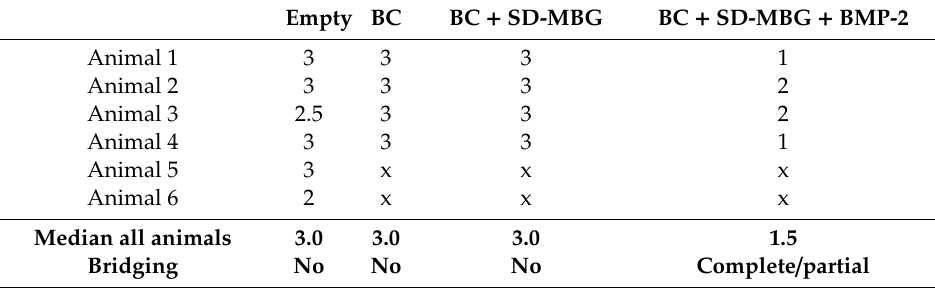
Table 2. Results of the evaluation of bridging states: 1 = complete bridging, 2 = partial bridging, 3 = no bridging. Only for the BMP-2 group, partial or complete bridging was observed in all animals. n = 4–6 animals per group. Scoring values stated as median form four di ff erent evaluators and summarized as the median of all animals per group. Empty: untreated control, BC: blood clot, SD-MBG: